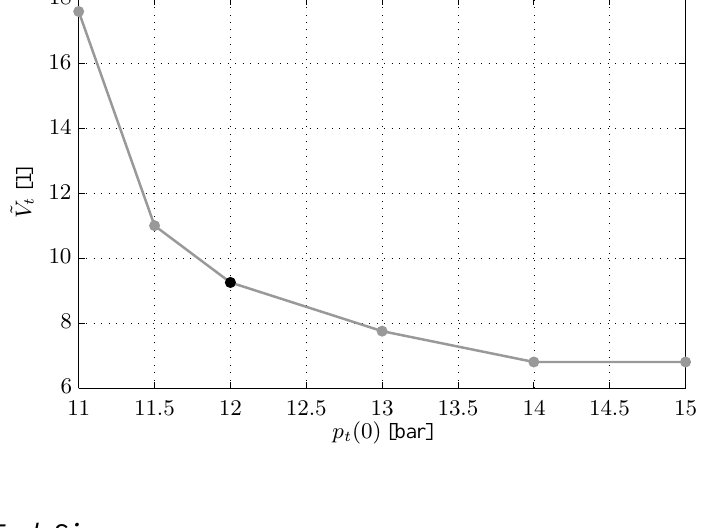
as a function of the initial tank pressure p t